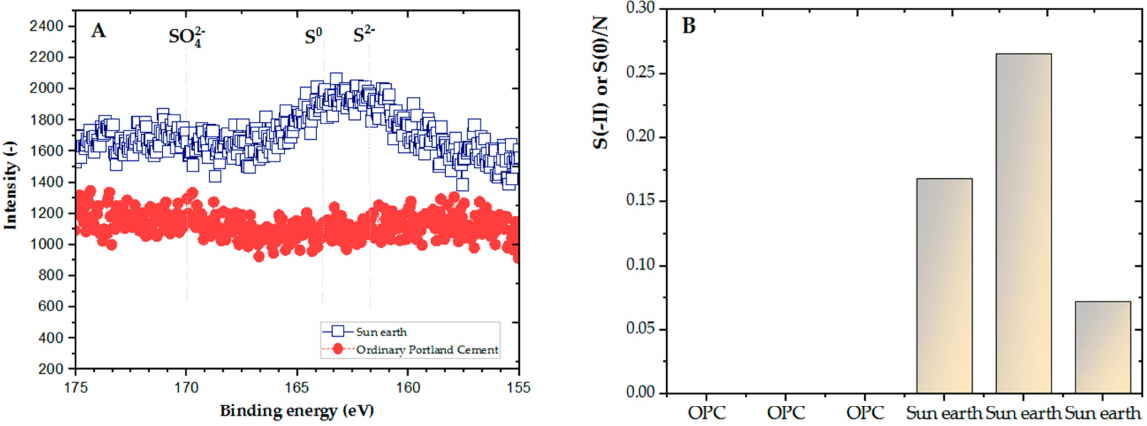
Figure 8. ( A ) Result of 2p3/2 spectrum of sulfur in the layer of sediment sludge after 66 days, ( B ) S/N